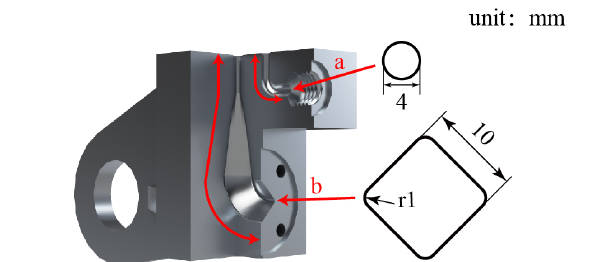
Table 2. Mesh and material definition.